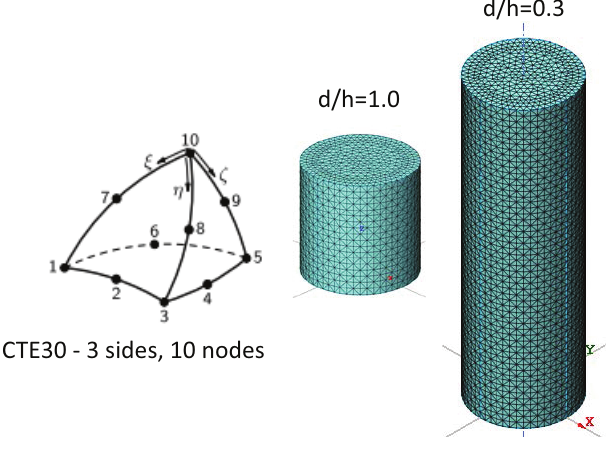
CTE30 - 3 sides, 10 nodes